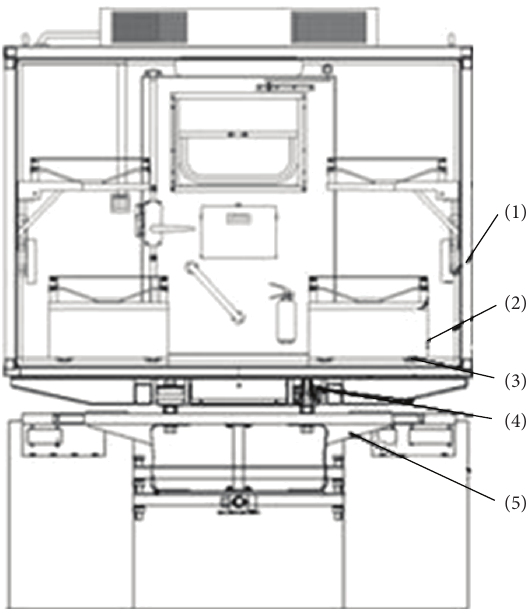
Figure 1: Ambulance damping system: (1) carriage, (2) stretcher base, (3) zero stiffness damper, (4) rubber damping shock absorber, and (5) coach chassis.